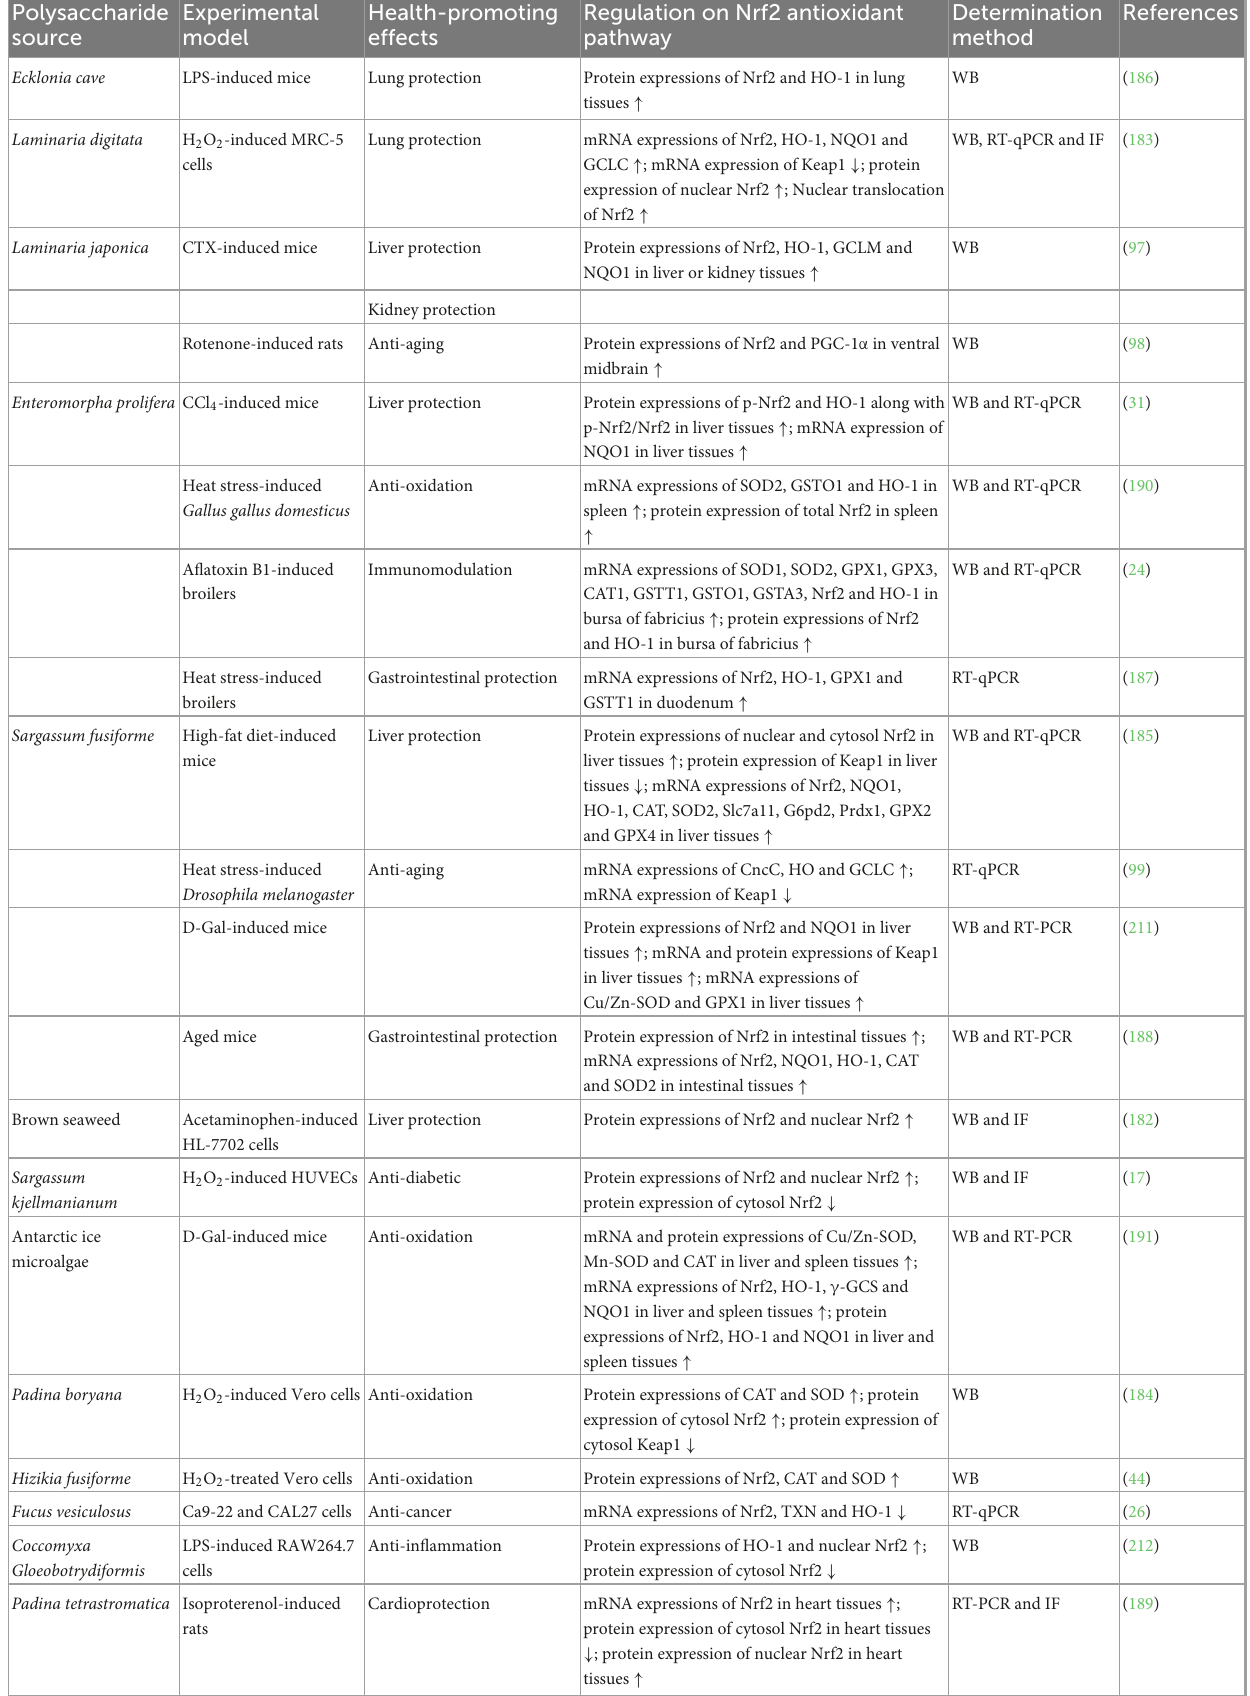
TABLE 3 Regulation of NPs from algae on Nrf2 antioxidant pathway for health-promoting